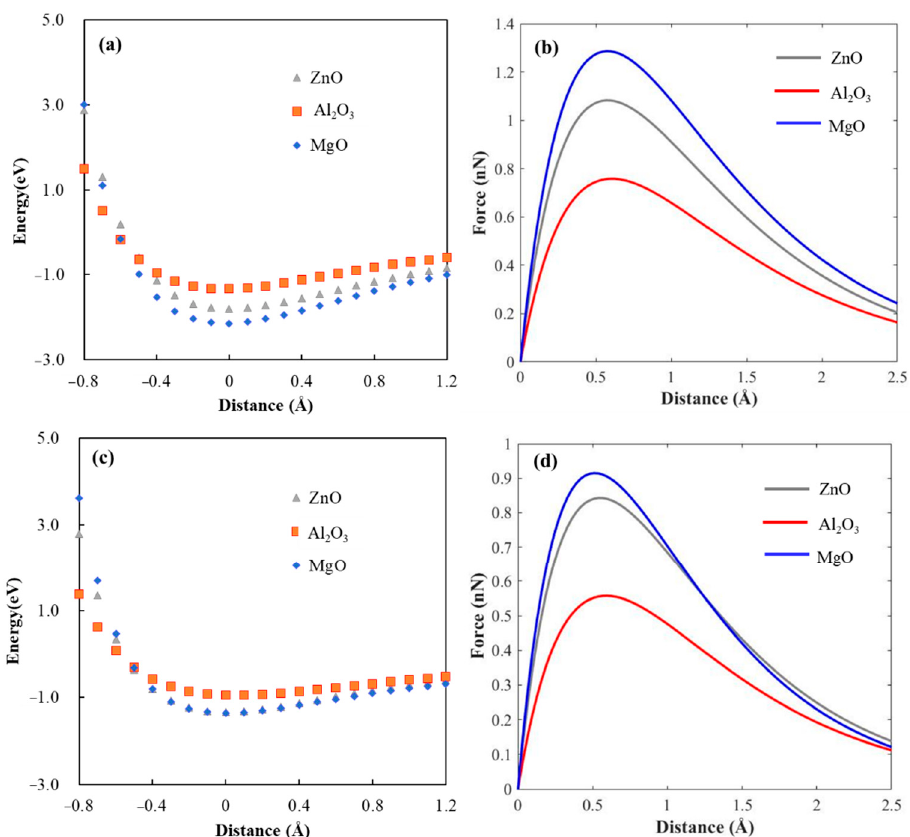
Figure 9. Energy − displacement plots and force − displacement plots for ( a , b ) dry environment and ( c , d ) water environment.